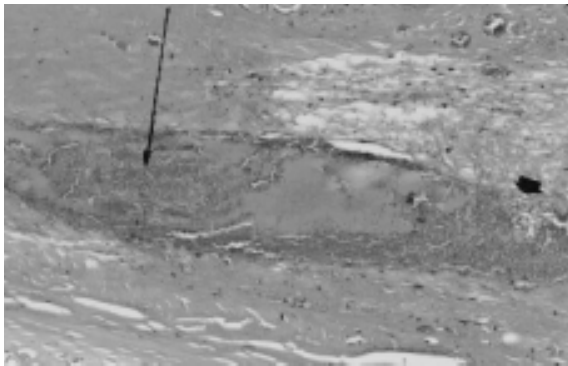
FIGURA 3 - Fotomicrografia mostrando destrui(cid:231)ªo da parede vascular (seta larga) e organiza(cid:231)ªo do trombo (seta